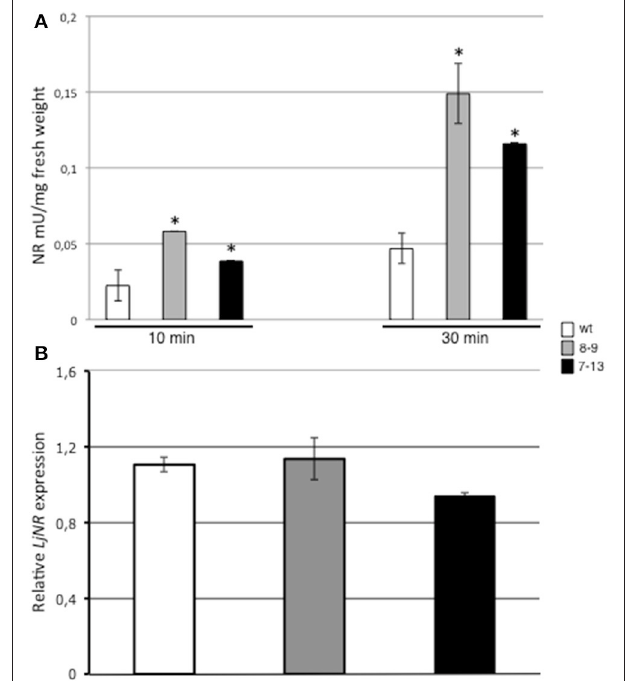
FIGURE 7 | NR enzyme activity and transcript levels in leaves of L. japonicus wild type and PII over-expressing plants. (A) NR activity in leaves of 3 weeks old plants grown in vitro on B5/2 Gamborg medium. Spectrophotometric values were measured at 10 and 30min from the starting of reaction in wild type, 7–13 and 8–9 lines. Data bars represent means and standard deviations of 4 samples from different plants. Asterisks indicate significant differences between wild type and transgenic plants ( p < 0.0001; VassarStats analysis of variance program). (B) Semi-quantitative RT-PCR analysis of LjNAR expression. Total RNAs were prepared from leaves of the same plants tested for NR activity. L. japonicus encoded UBI was used as a reference gene to normalize the expression of LjNAR . Plant genotypes are indicated. Data bars represent means and SE of the values obtained from 4 biological samples.